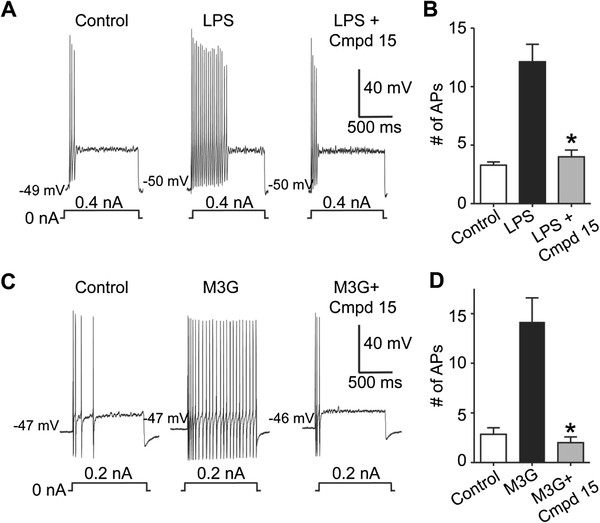
Lipopolysaccharide and morphine-3-glucuronide increase the excitability of nociceptive dorsal root ganglion neurons. Current clamp recordings were performed on small (≥30 μm) to medium (≥40 μm) dorsal root ganglion (DRG) neurons (L1-6) from naïve rats. Firing of two to four action potentials (APs) was elicited by a 1 second depolarizing current injection (ranging from 0.1 to 0.6 nA depending on the cell) every 30 seconds. (A) Representative recordings demonstrating that application of 2 μg/mL lipopolysaccharide (LPS) increases the number of elicited APs and Compound 15 can reverse this effect. (B) Group data demonstrating that LPS caused a significant increase in DRG AP firing that is reversed with Compound 15. (C) Representative recordings demonstrating that application of 3 μM morphine-3-glucuronide (M3G) increases the number of elicited APs and Compound 15 can reverse this effect. (D) Group data showing that M3G caused a significant increase in DRG AP firing that is reversed by Compound 15.